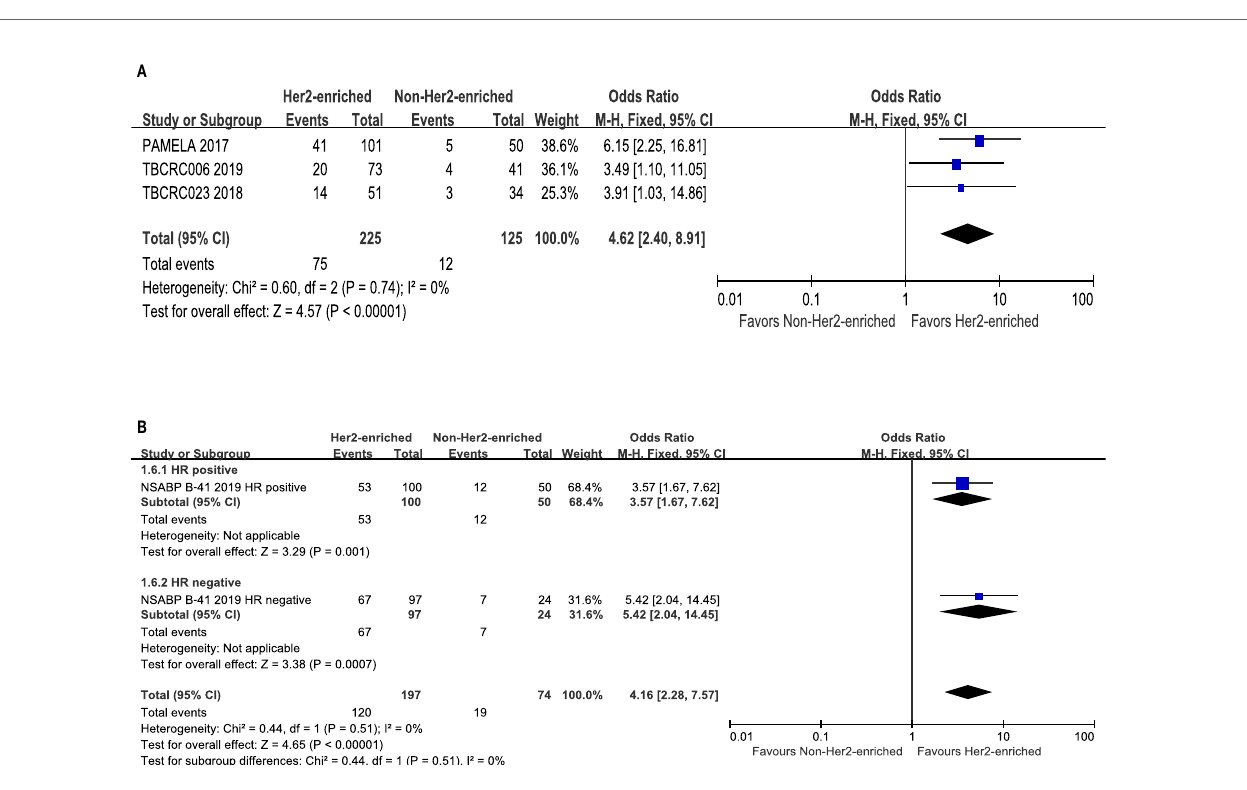
FIGURE 6 | Forrest plot of odds ratio (OR) used to evaluate the correlations between nintrinsic molecular subtype subgroups (HER2-enriched vs. non-HER2-enriched) and pCR as based on: (A) endocrine therapy used; (B) hormone receptors status. CI, con fi dence interval; HER2, human epithelial growth factor receptor 2; pCR, pathological complete